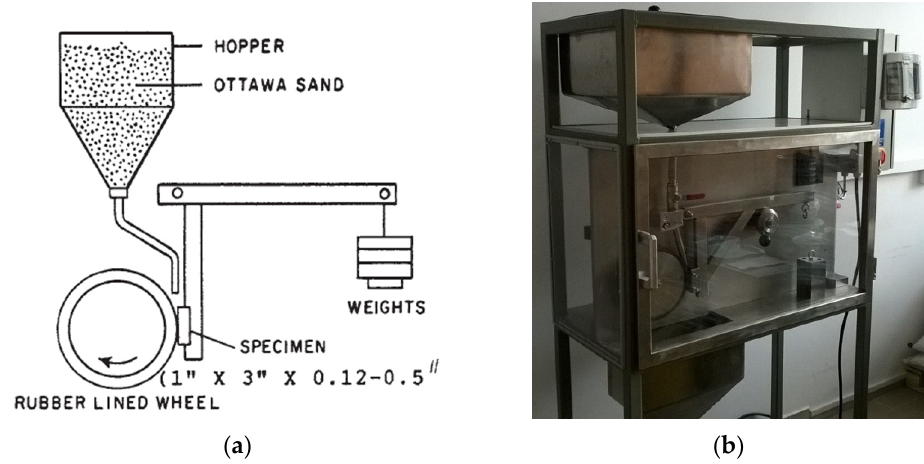
Figure 1. ( a ) Dry sand/rubber wheel abrasive test schema according to ASMT G65 [29]; ( b ) general view of the test stand according to ASTM G65 requirements.